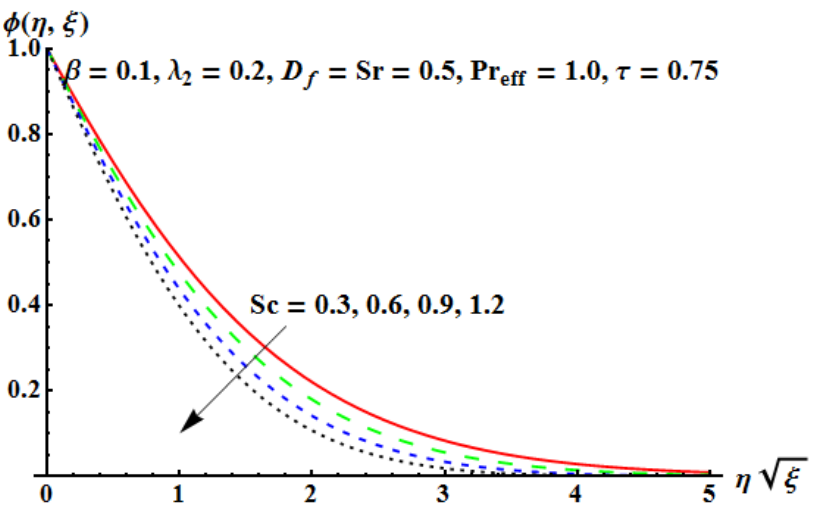
Figure 12. Influence of Sc on φ ( η , ξ ) .